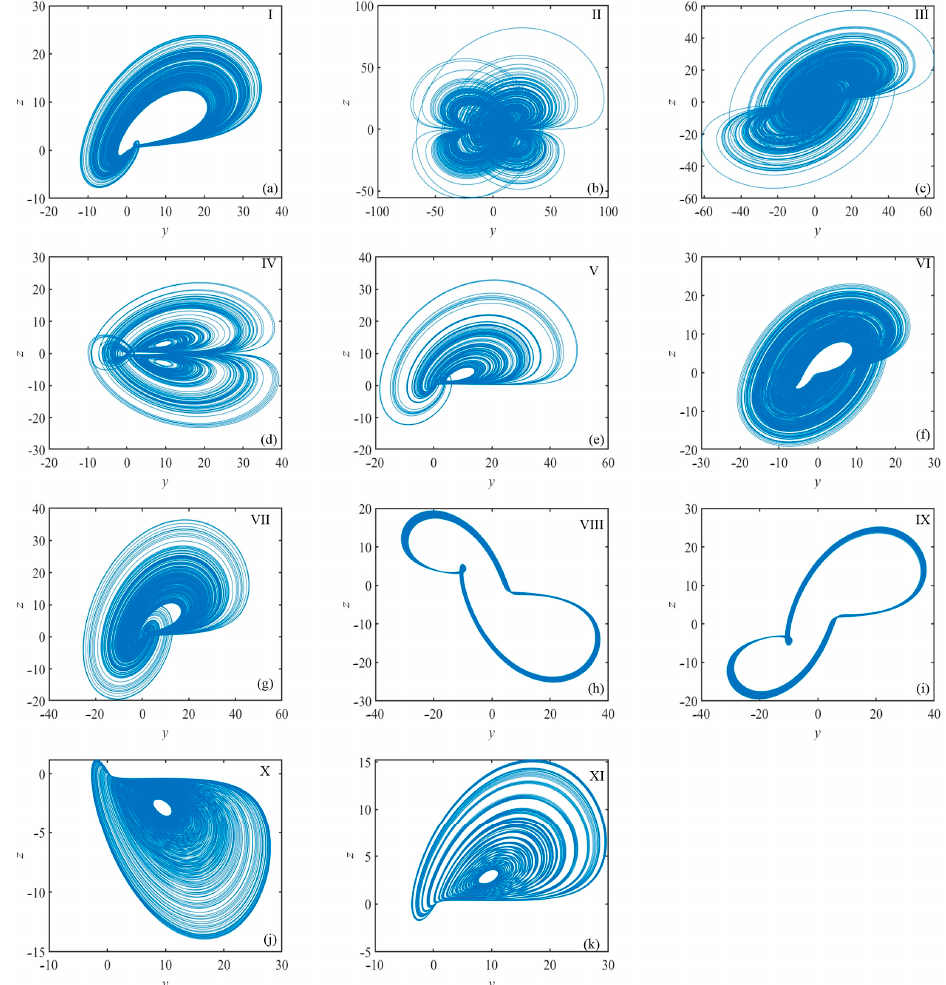
Figure 2. Hidden chaotic attractor of Type I-Type XI (Y-Z plane) under initial condition of (1, 1, 1, 1, 1, 1), and b = 0.01, c = 5, k = 7, g = 0.05, l = 6, ( a ) a = 3, c = 7, d = 31; ( b ) a = 5, c = 7, d = 31; ( c ) a = 3, c